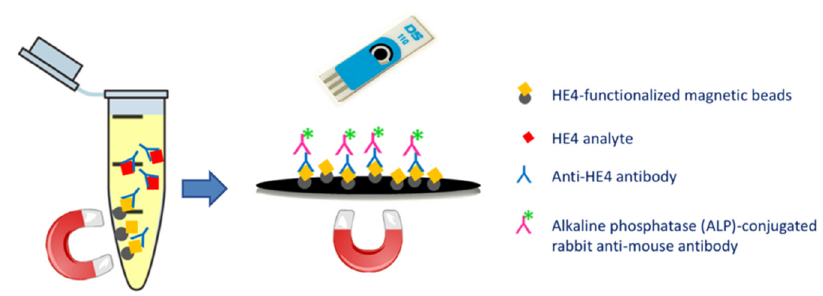
Scheme 1. Working principle of the electrochemical immunomagnetic assay on MBs